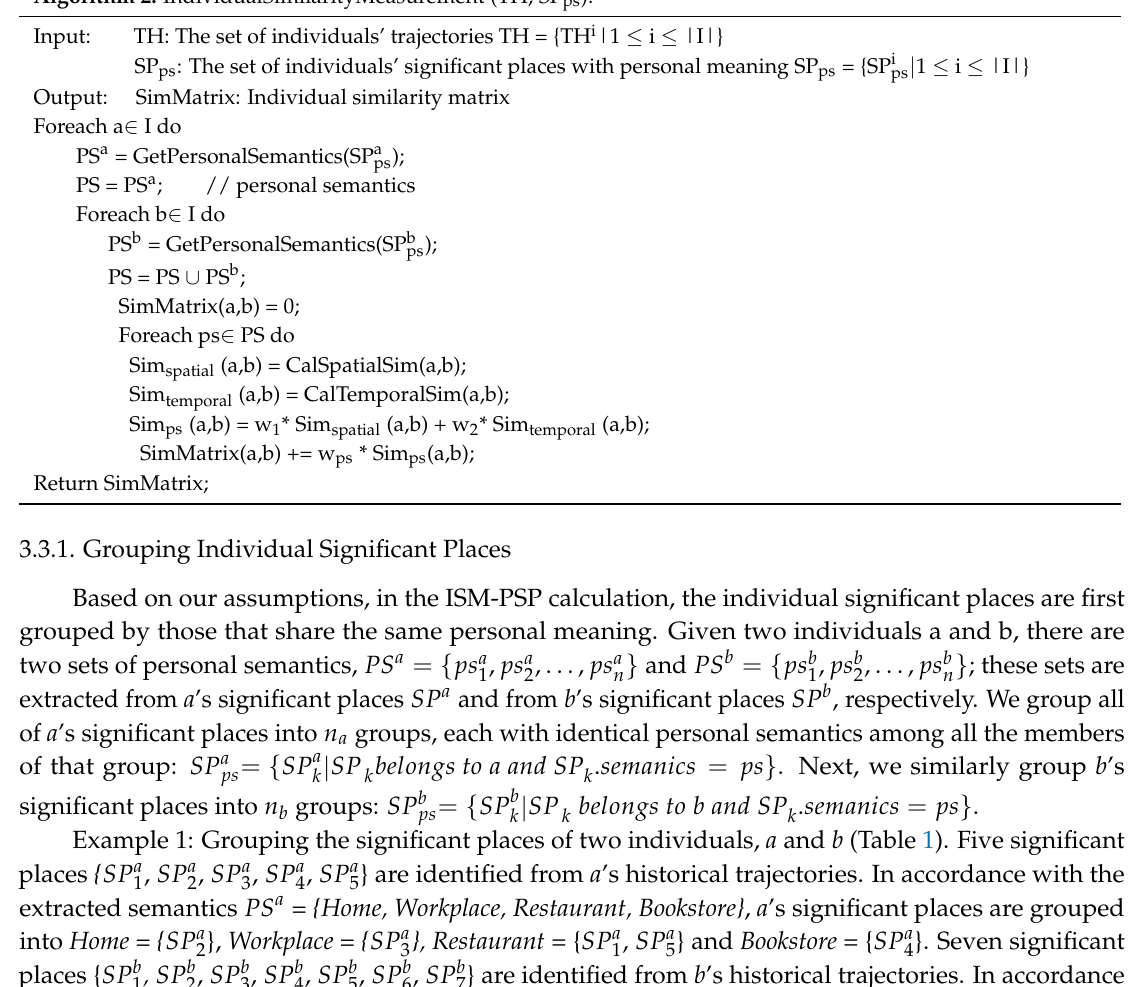
Algorithm 2. IndividualSimilarityMeasurement (TH, SP ps ).